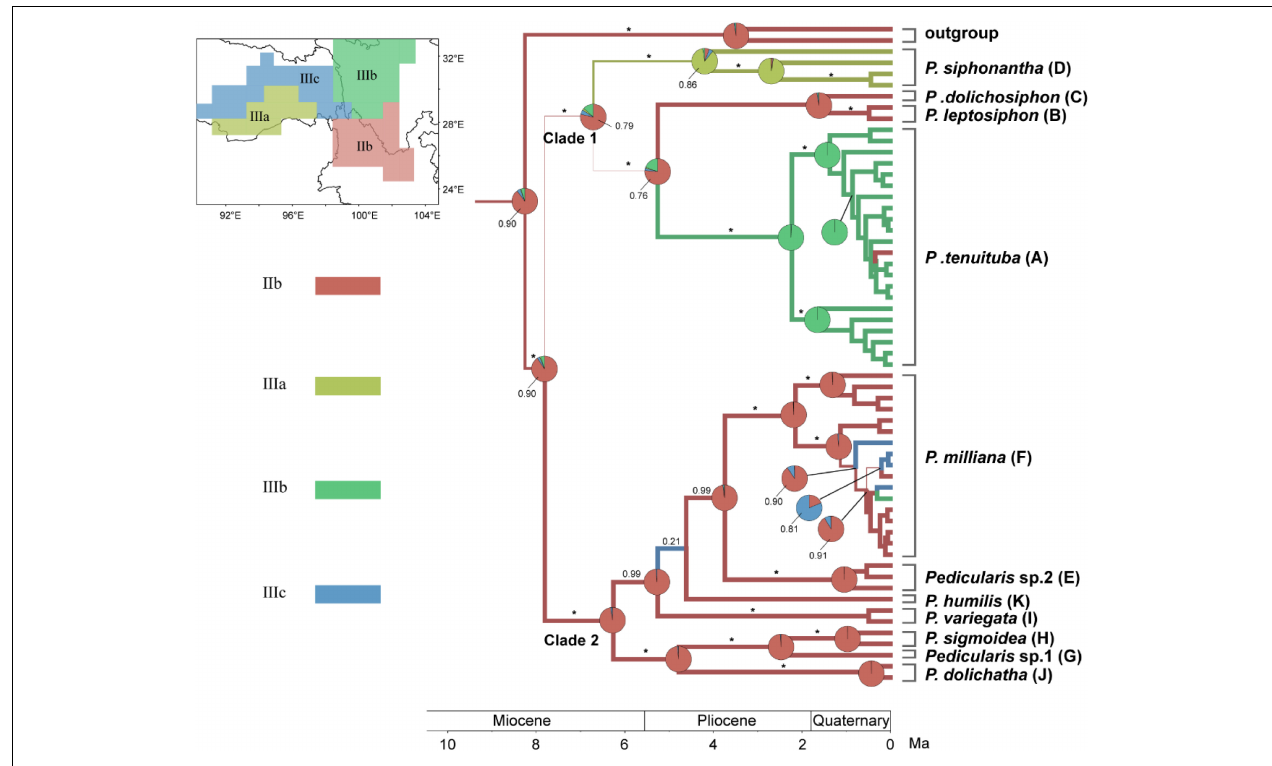
FIGURE 7 | Bayesian phylogeographical reconstruction of ancestral area of the Pedicularis siphonantha complex in the Sino-Himalayan region using the modified nrITS + ptDNA dataset (see above). Pie charts and thickness of branch represent the marginal probabilities for potential ancestral areas with each subregion (Liu et al., 2021), represented by a different color. BI PPs are above branches (* =